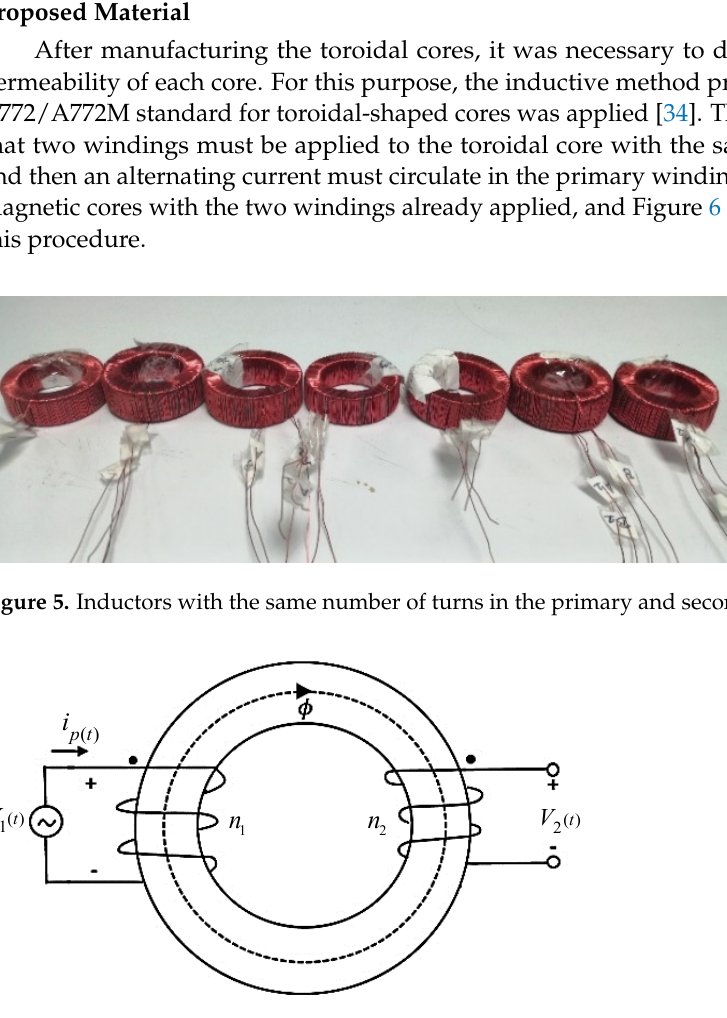
Figure 6. Proposed method with ASTM A772/A772M